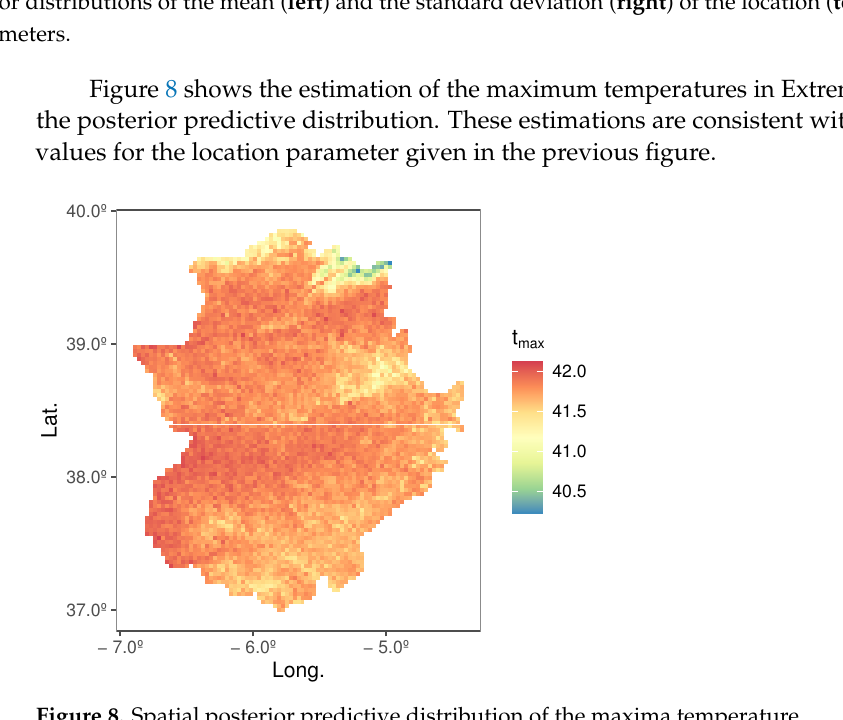
Figure 8. Spatial posterior predictive distribution of the maxima